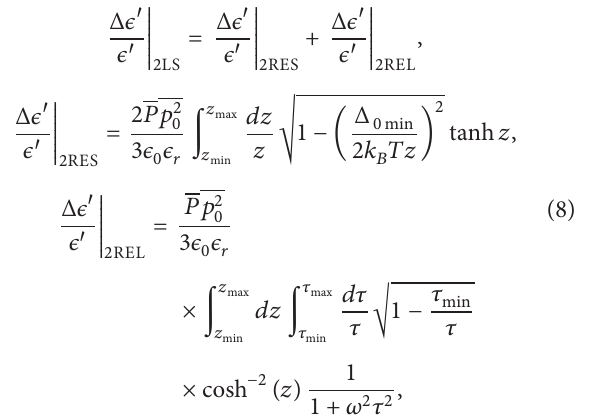
, each being ATS < 𝑥 𝑥 → 0 2 LS and that ATS ATS